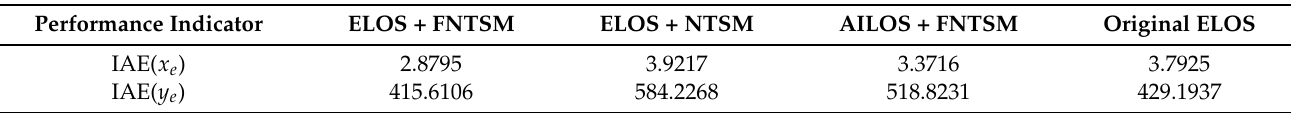
Table 4. Performance indicator of path-following (curve). Performance